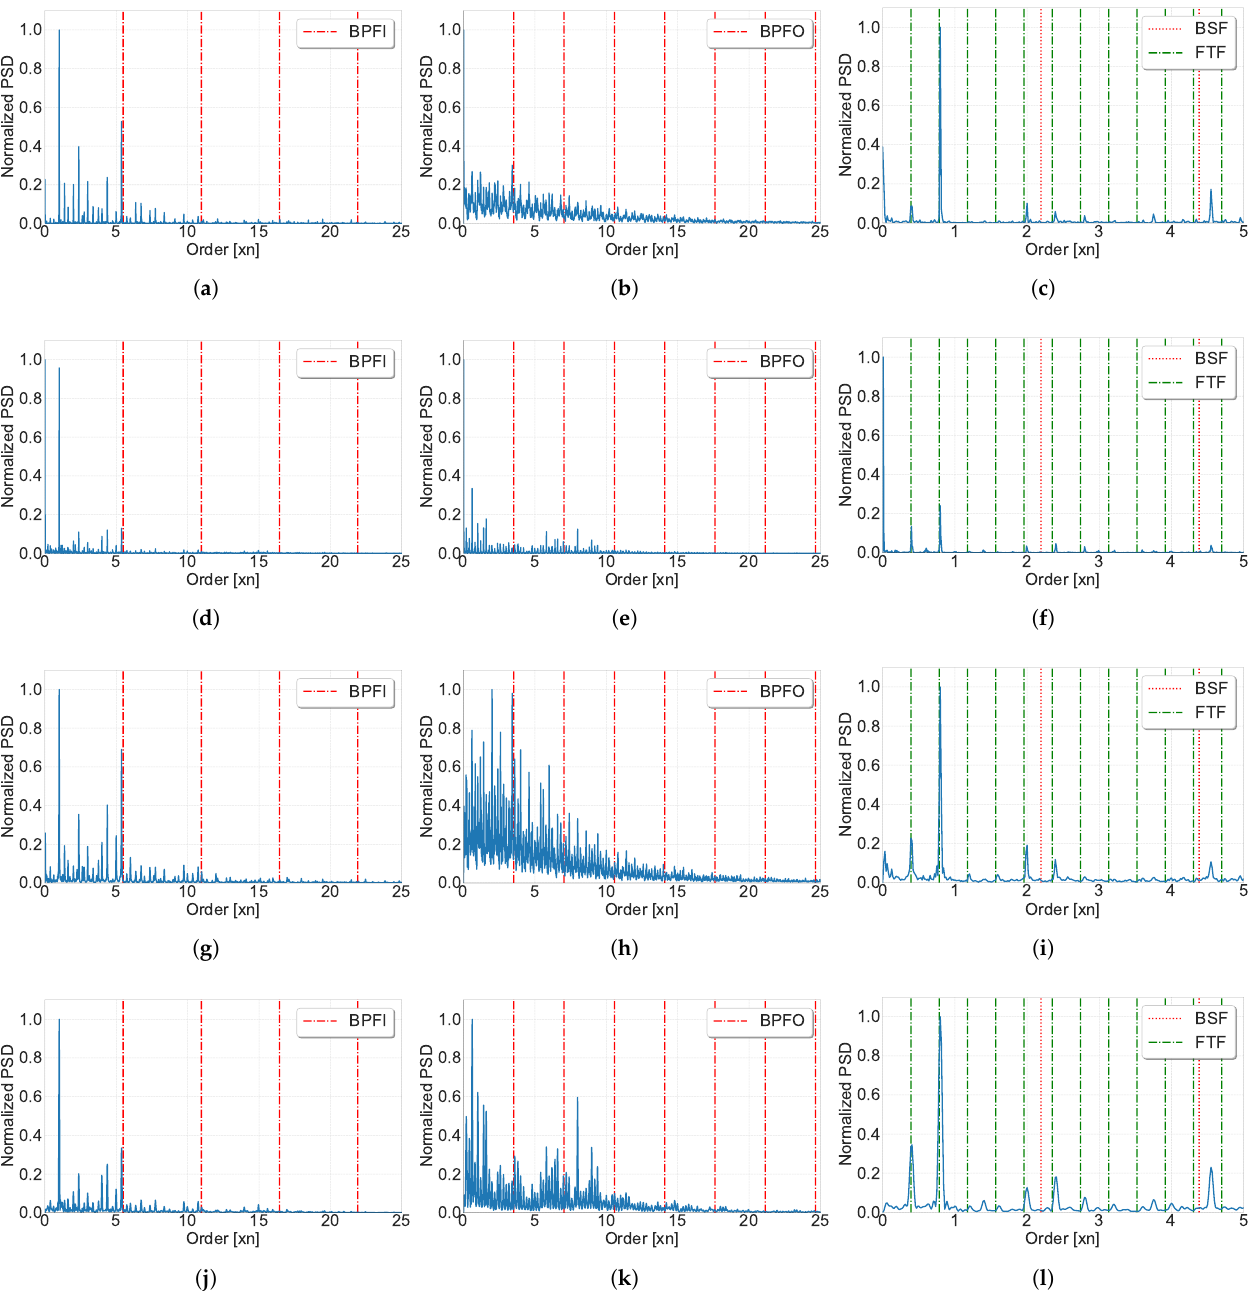
Figure 11. Envelope-spectrum examples of failures (IR (left column), OR (middle column), and Ball (right column)) computed by SK (top row), SE (second row), SSK (third row), and SSE (fourth